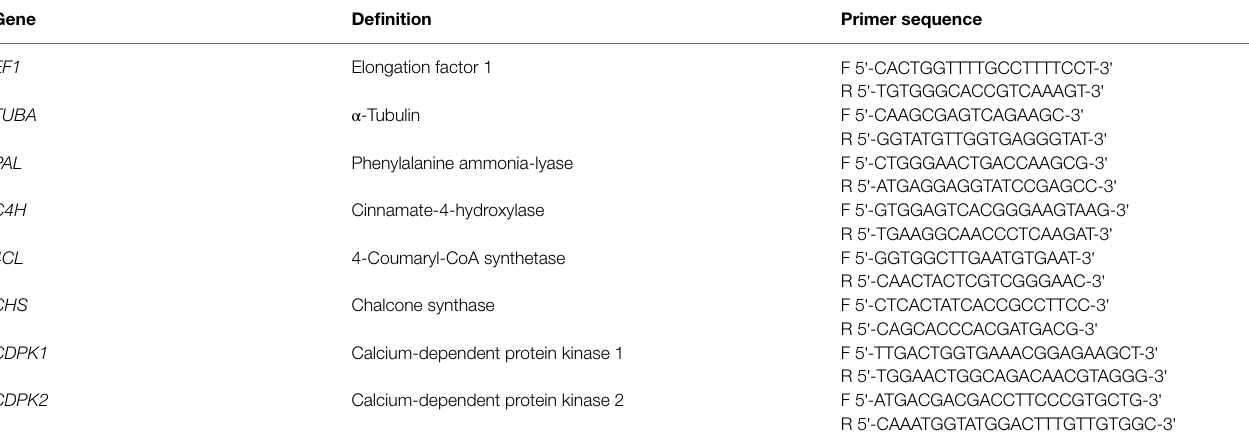
TABLE 1 | Primer sequences used for the analysis of expression level of target genes. Gene Definition Primer